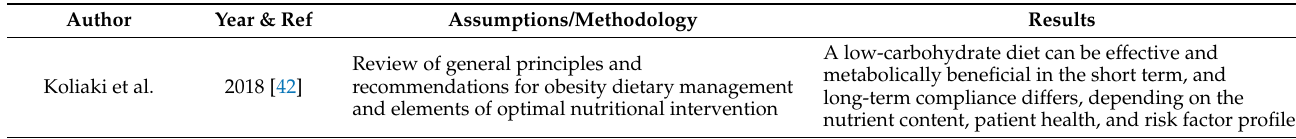
Table 2. Effects of Low/Very Low carbohydrate